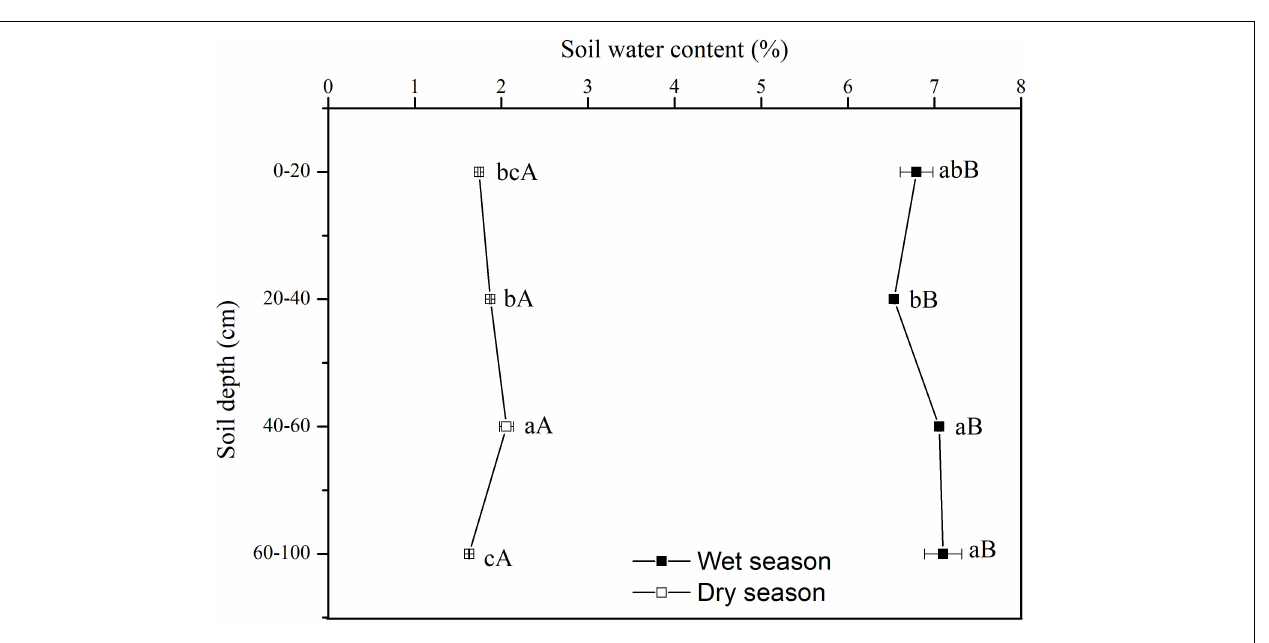
FIGURE 3 | Variation in vertical profile of soil water content (SWC) in dry and wet seasons. Error bars represent standard errors of mean SWC ( n = 9).Different lowercase letters represent the significant differences in SWC among different soil depths in dry or wet seasons at the 0.05 level. Different capital letters represent significant differences in SWC at each soil depth between dry and wet seasons at the 0.05